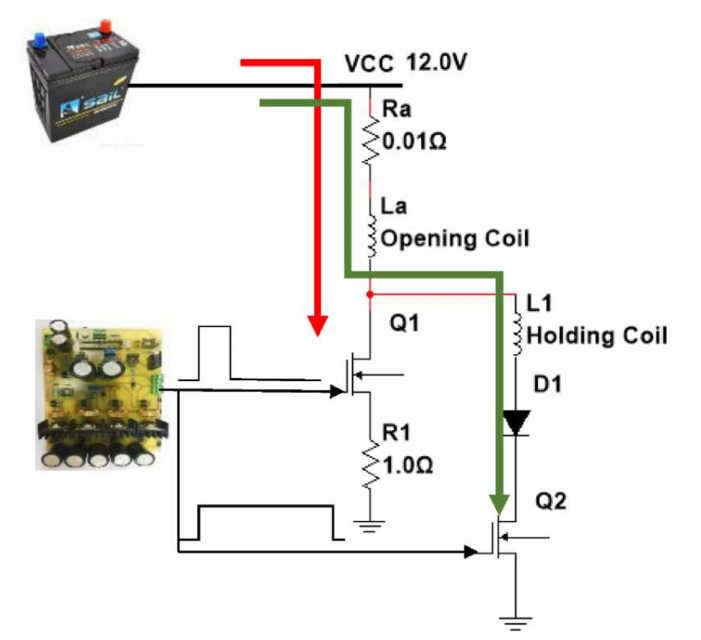
Figure 3. Electrical driving circuit diagram for the HP GDI injector with three pulse width and PWM